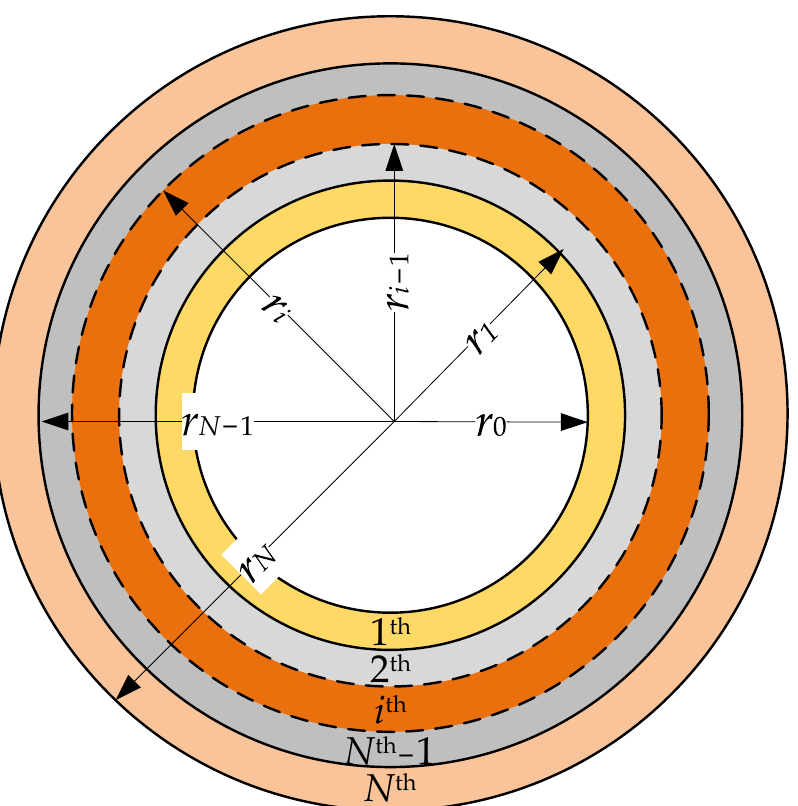
Figure 2. C ross section of the outer conductor of the multilayer coaxial waveguide. Figure 2. Cross section of the outer conductor of the multilayer coaxial